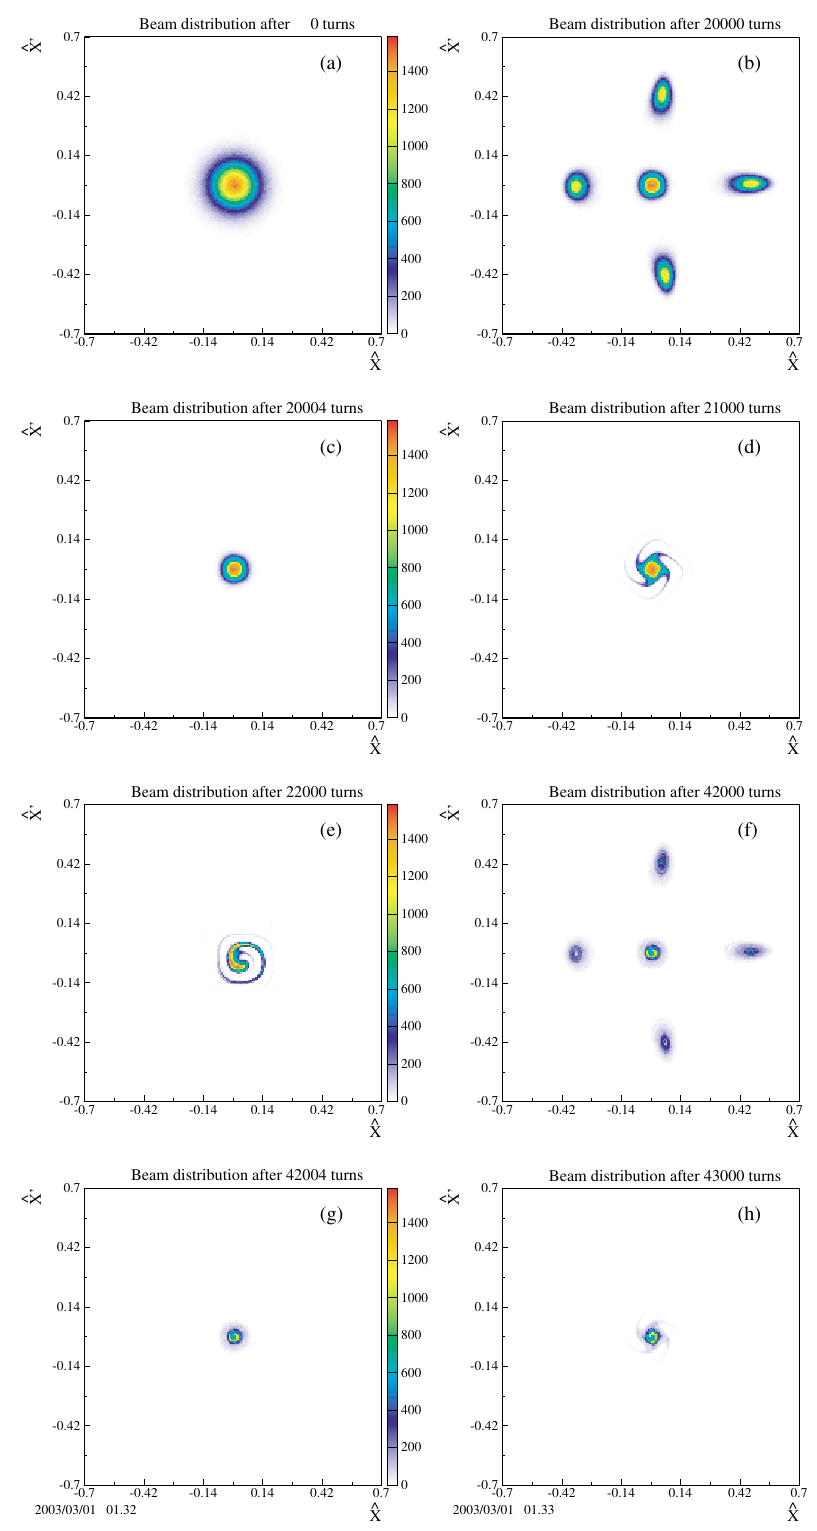
FIG. 13. (Color) Beam distribution during the multiple multiturn extraction for the fourth-order resonance ( 8 : 1 (cid:9) 10 5 initial conditions). The initial distribution is a Gaussian centered on zero, with standard deviation (cid:21) (cid:1) 0 : 07 . (cid:14) (cid:1) (cid:6) 1 : 5 , but the beam size is increased by repeated kicks after each